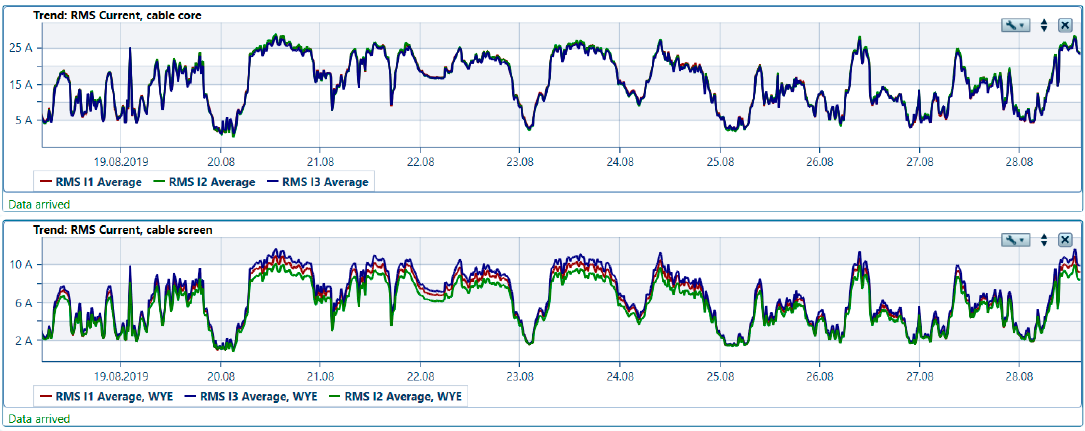
Figure 15. Currents in cable cores and screens; (Rogowski coils measuring range set to 30A [58]).